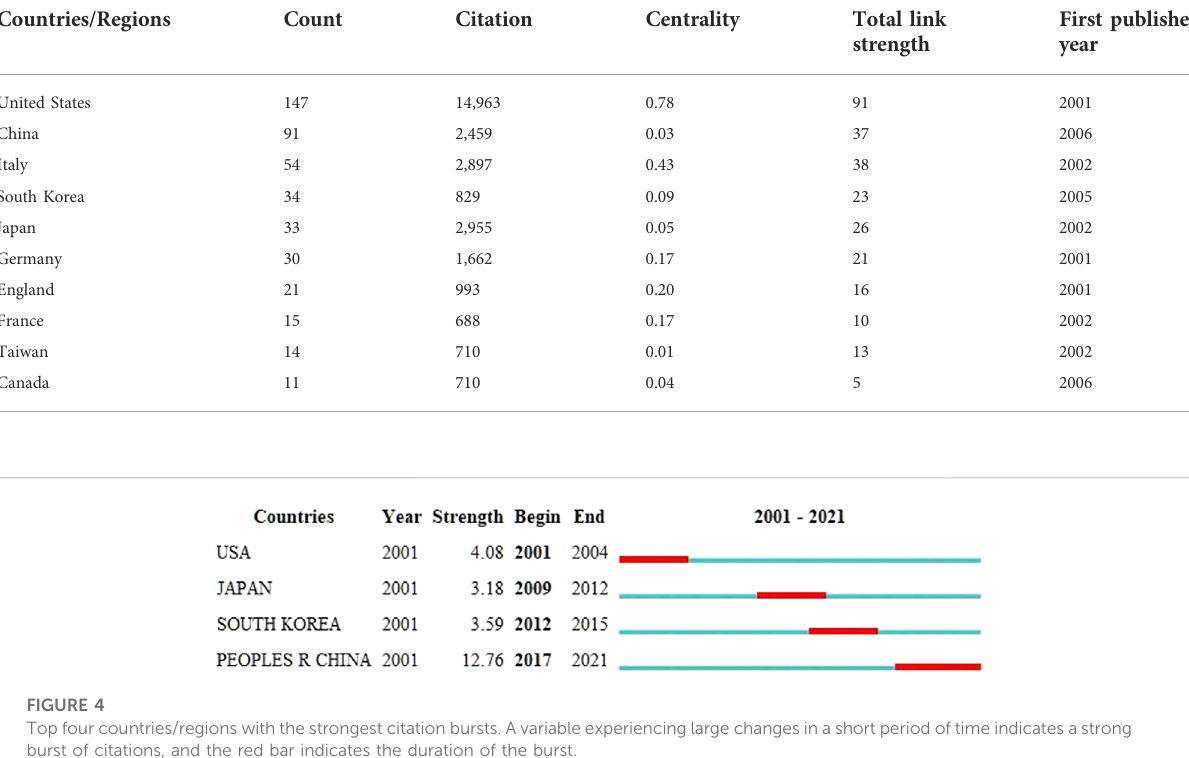
TABLE 1 Top 10 most productive countries and regions with publications.